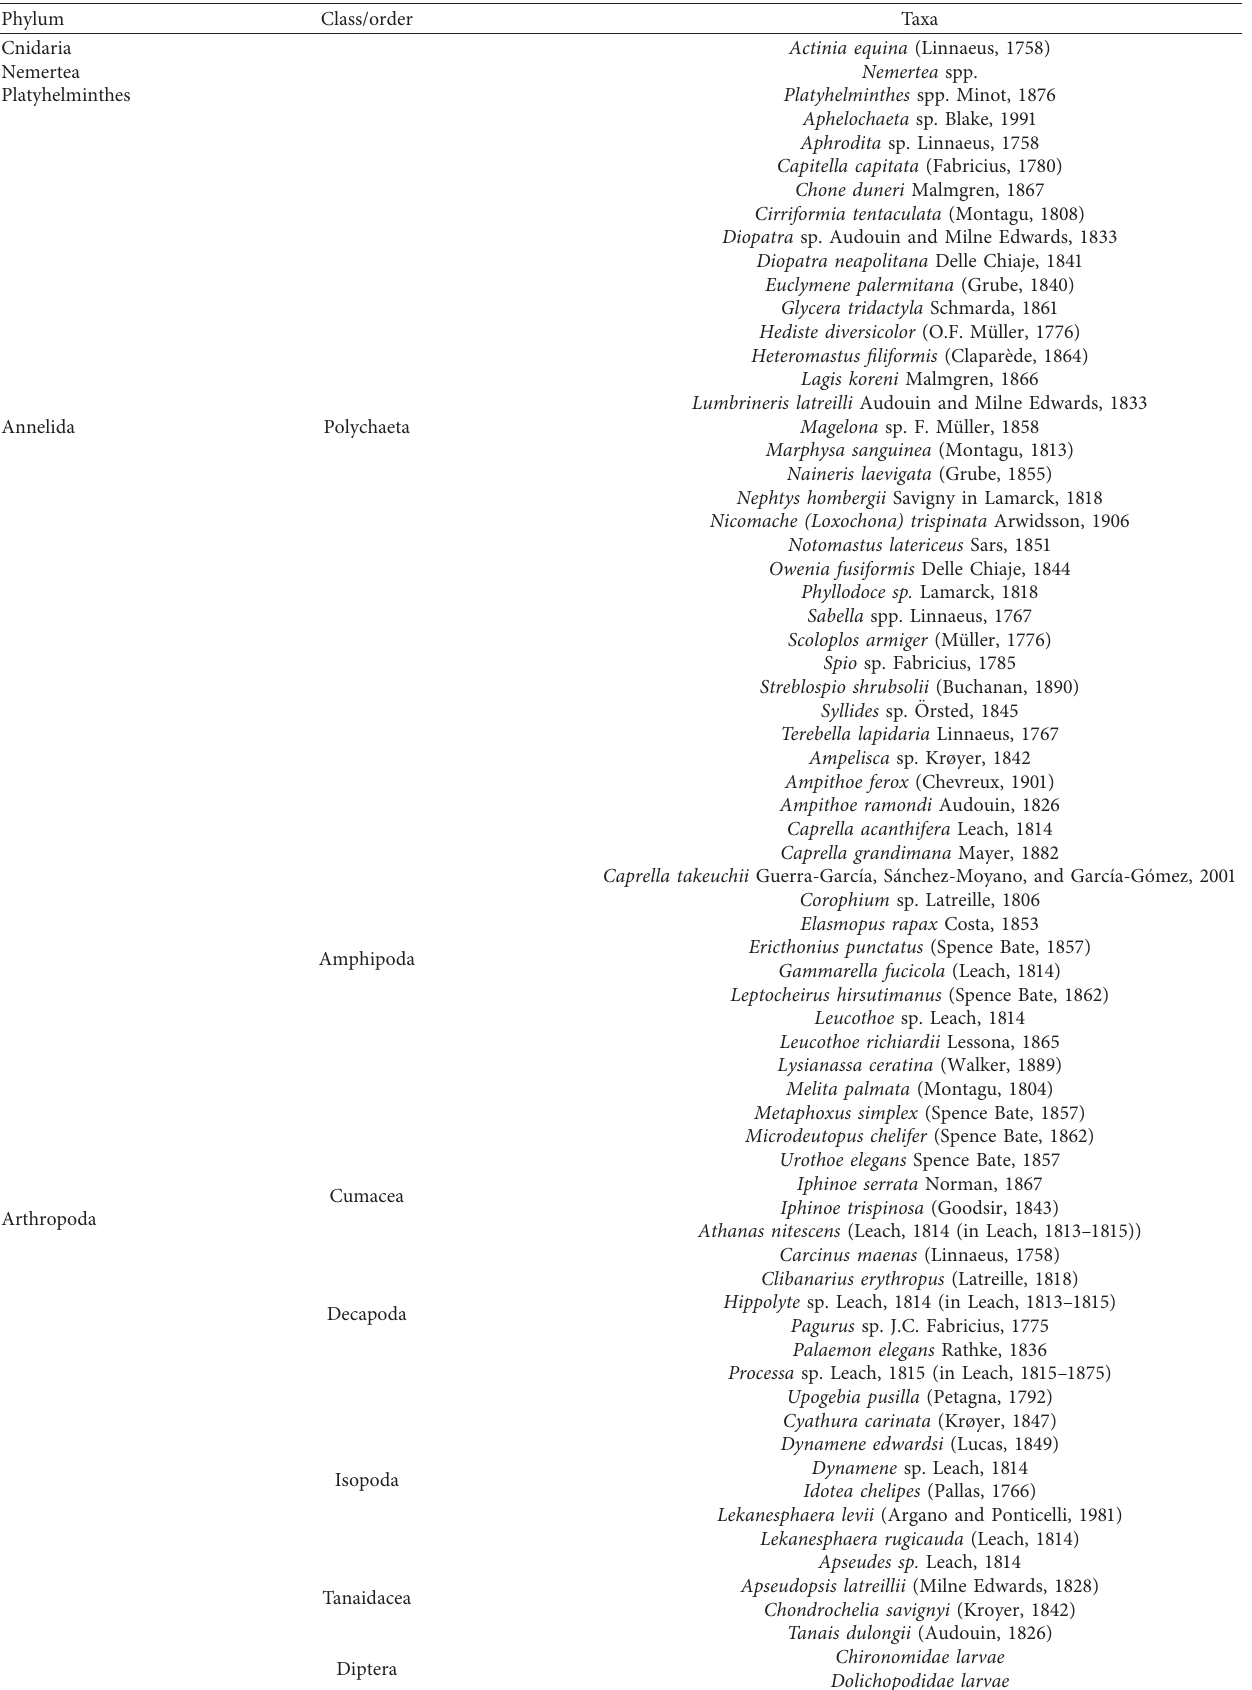
Table 9: List of the taxa found in Zostera noltei beds in the study